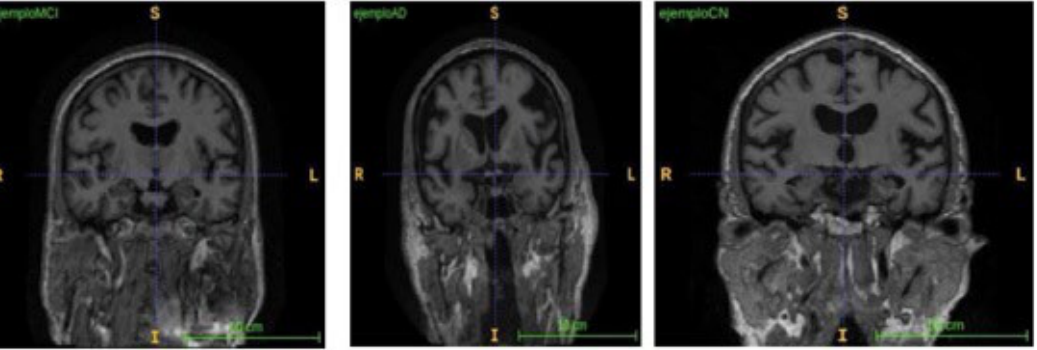
Figure 1. Sample multimodal coronal MRI collected from ADNI dataset for the same patient.